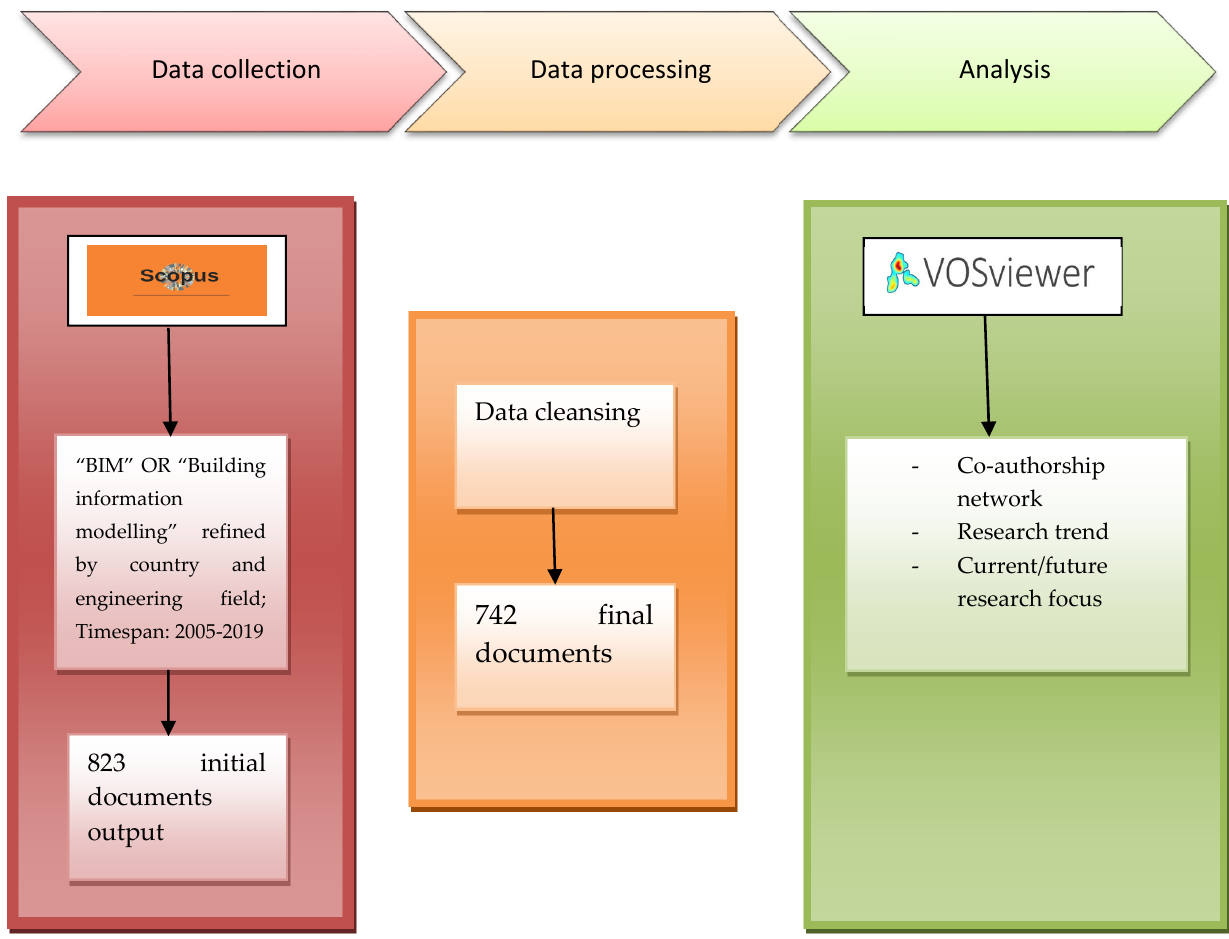
Figure 2. Research